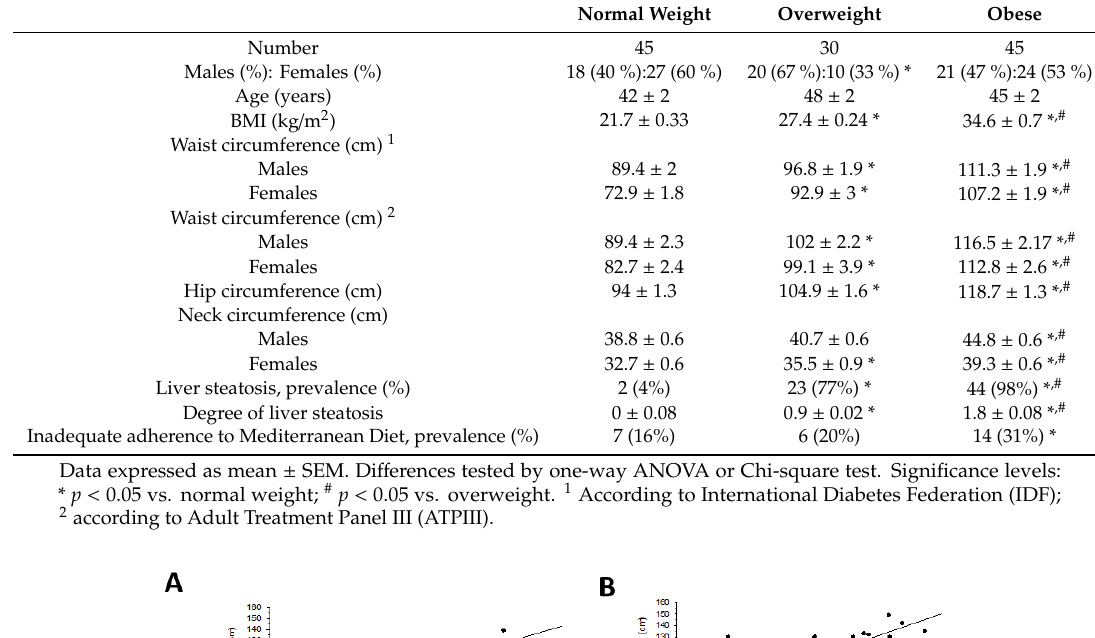
Table 1. Clinical characteristics of the study groups.